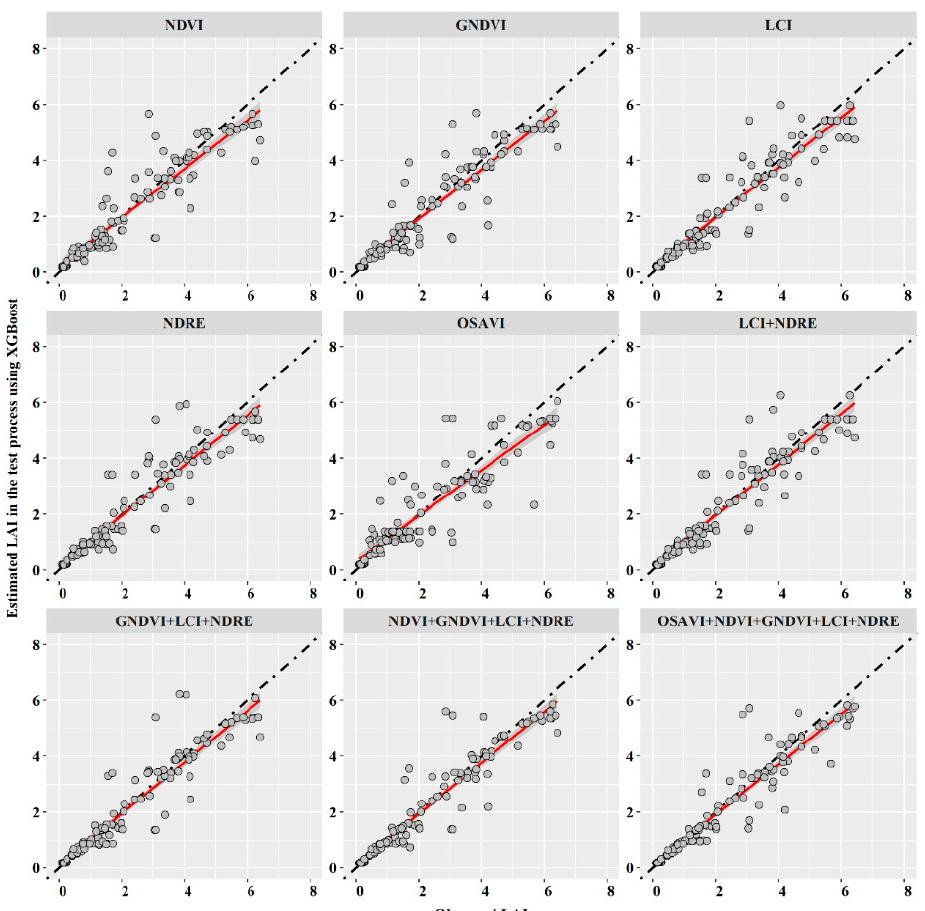
Figure 11. Relationship between observed and estimated leaf area index (LAI) of rice by Extreme Gradient Boosting model (XGBoost) with vegetation indexes (VIs) in the test process. Dash lines and red solid lines are the 1:1 lines and the linear fitting lines, respectively. The shaded areas indicate the range of 95% prediction bands.